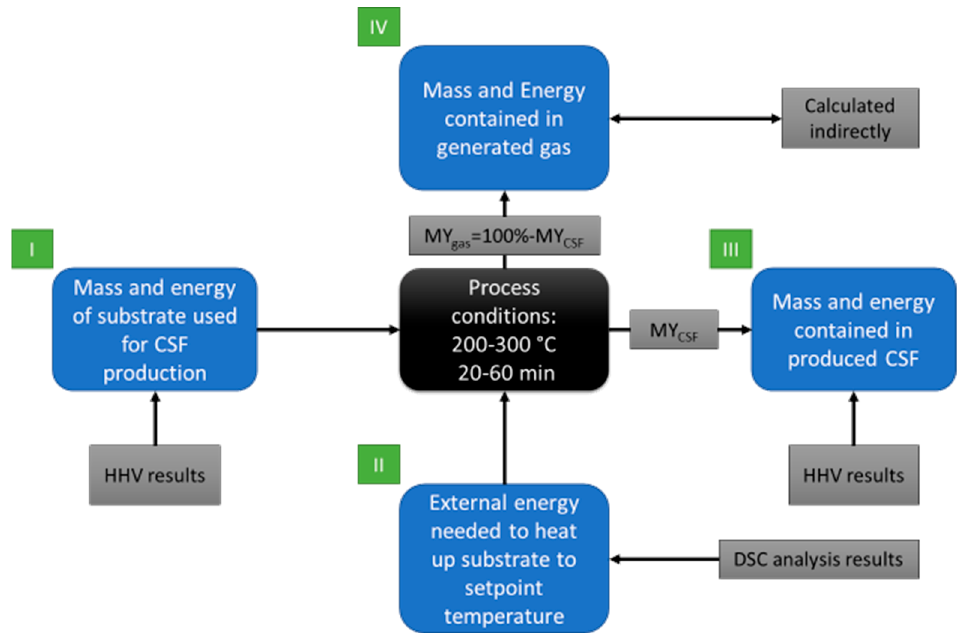
Figure 1. Scheme of mass and energy balance determination.